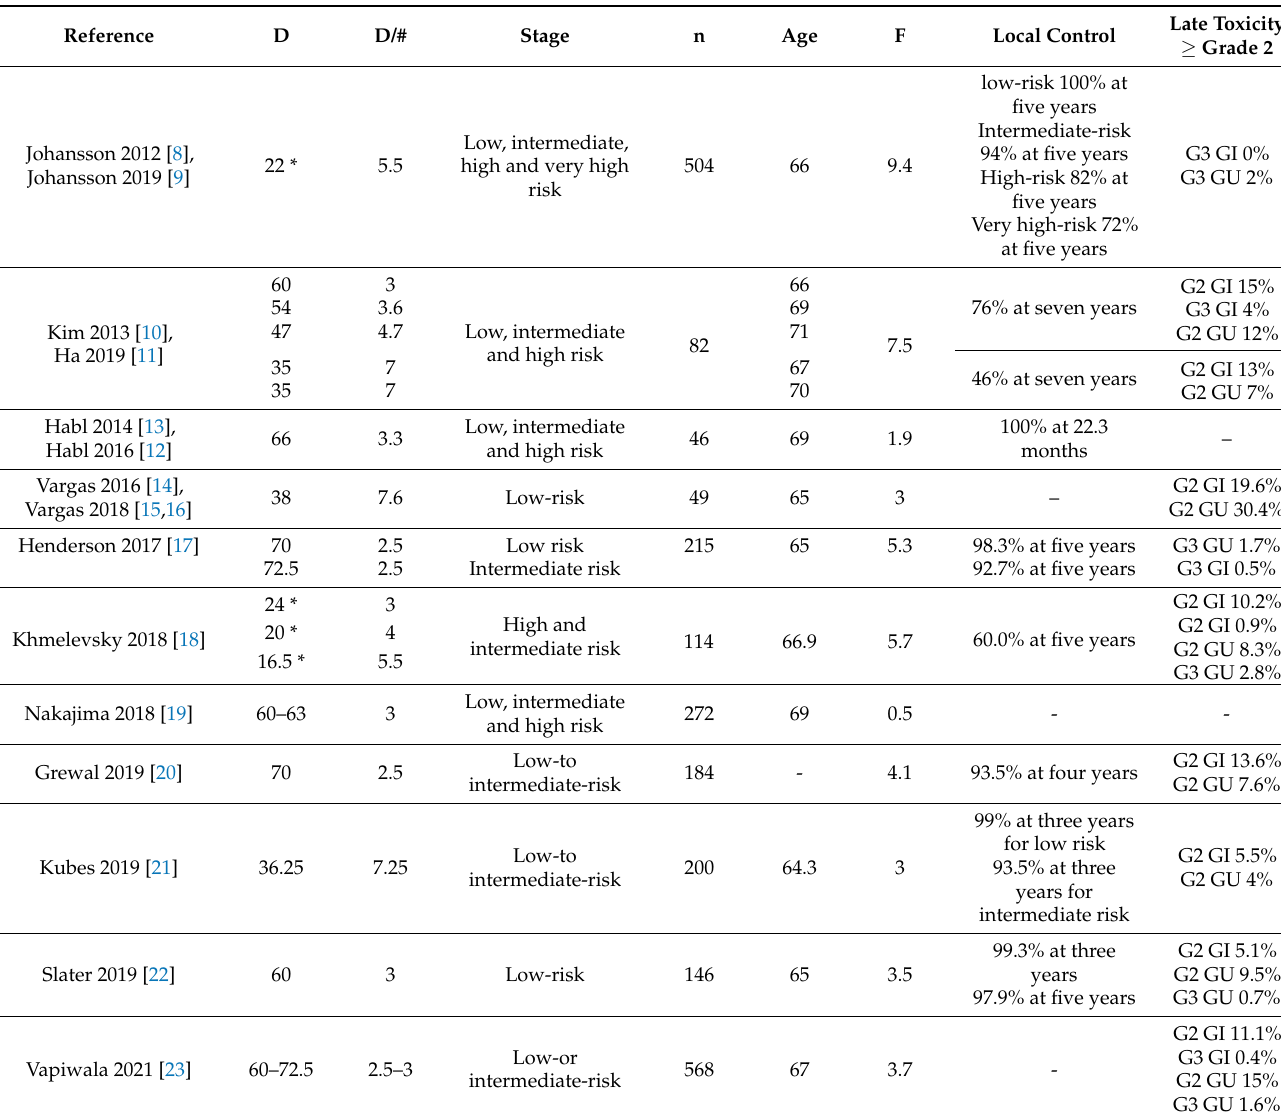
Table 1. Prostate